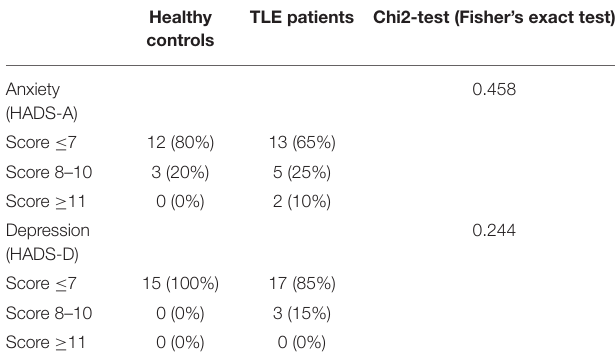
TABLE 6 | Results of each group on HADS. Healthy TLE patients Chi2-test (Fisher’s exact controls